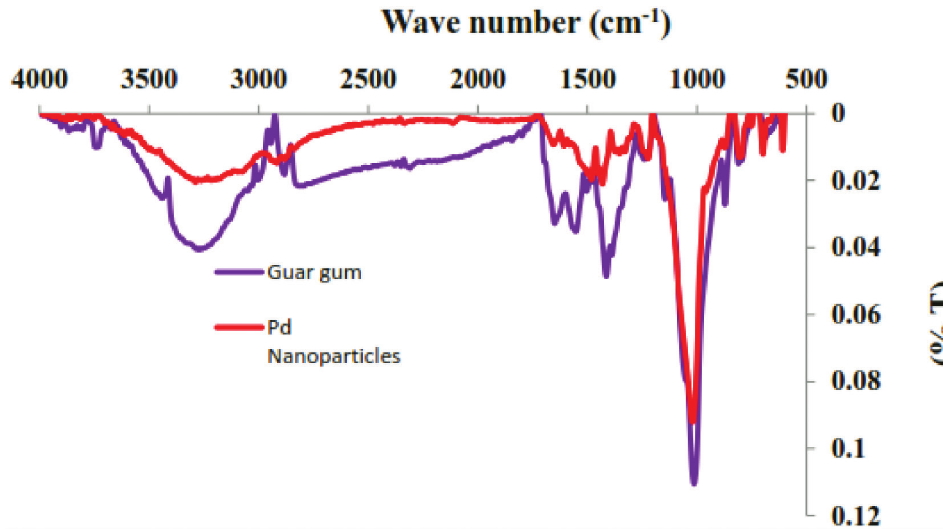
Figure 5: The combine FTIR spectra of guar gum and palladium nanoparticles.